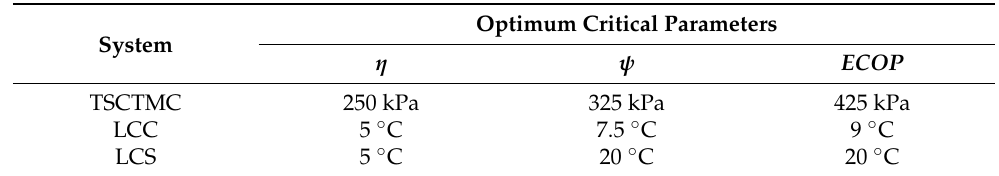
Table 7. Optimum inter-stage pressures and intermediate temperatures for hybrid cooling systems in case 1.